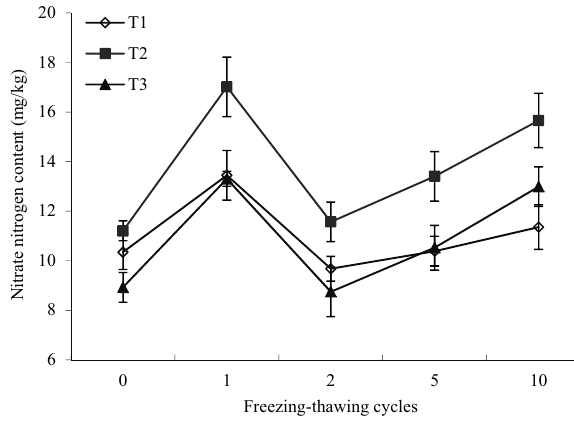
Figure 2: Changes of nitrate nitrogen content in reconstructed soil with di ff erent freezing – thawing cycles.